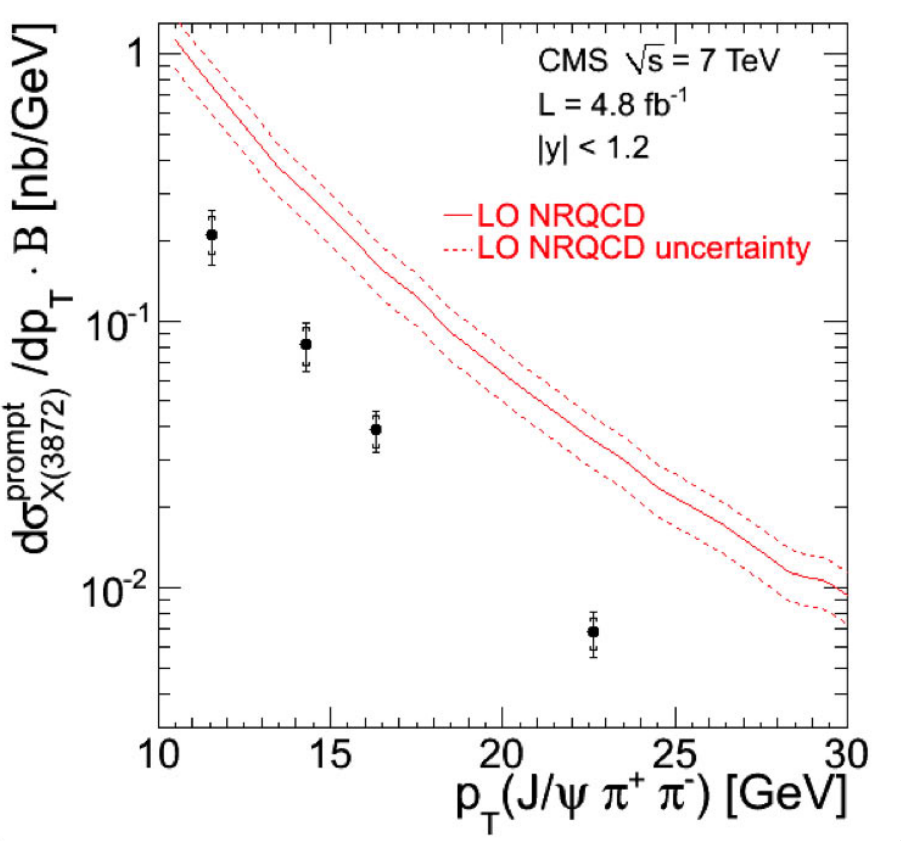
Figure 1. Measured di ff erential cross section for prompt X (3872) production times branching fraction of X (3872) → J /ψπ + π − as a function of p T . The inner error bars indicate the statistical uncertainty while the outer error bars represent the total uncertainty. Theoretical prediction as explained in the text is shown by the solid line with the dotted lines representing the related